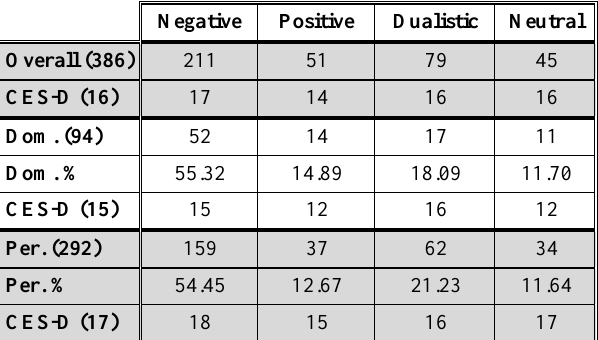
Table 10 : CES-D based on social interaction feelings